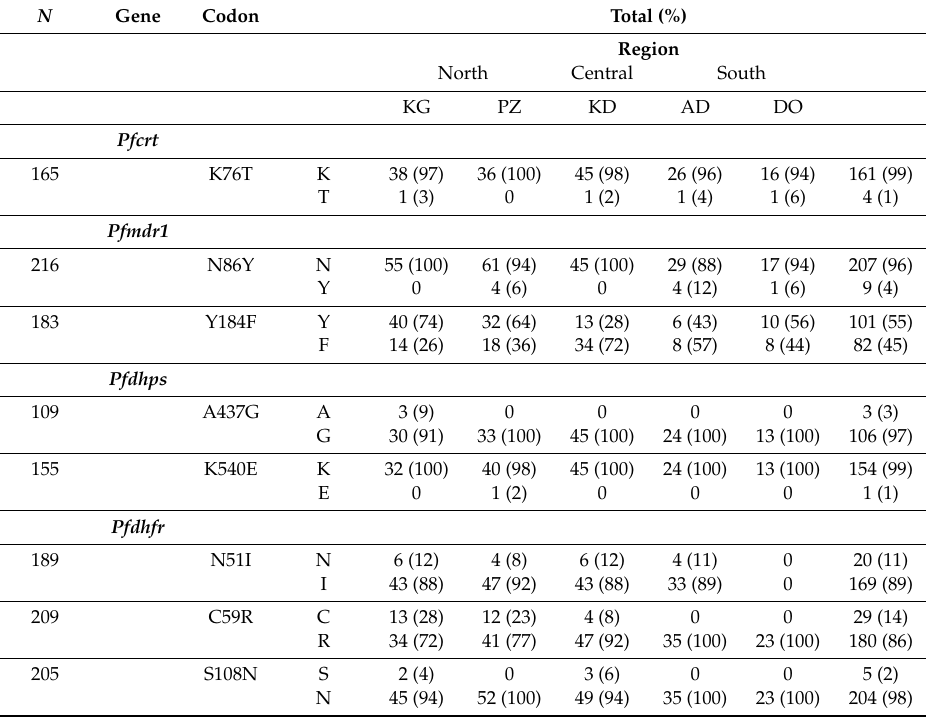
Table 2. Prevalence of the Pfcrt , Pfmdr1 , Pfdhfr , and Pfdhps point mutations in isolates from the three geographical regions (five di ff erent sites) in Ghana.